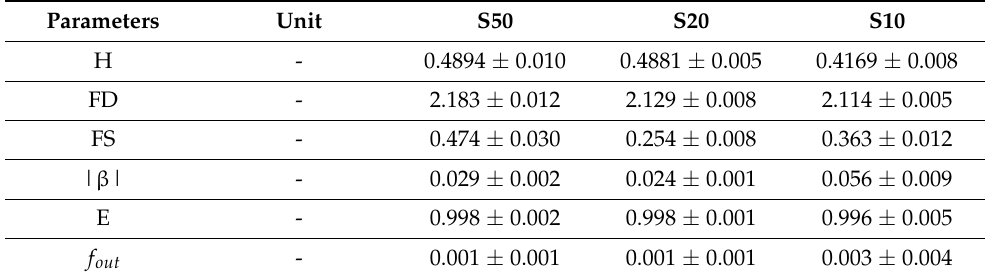
Table 4. Fractal parameters of leaf surface abaxial side as a function of the scale size. The average results were expressed as mean values and standard